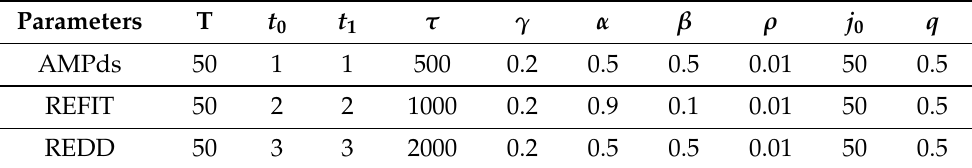
Table 1. Parameter